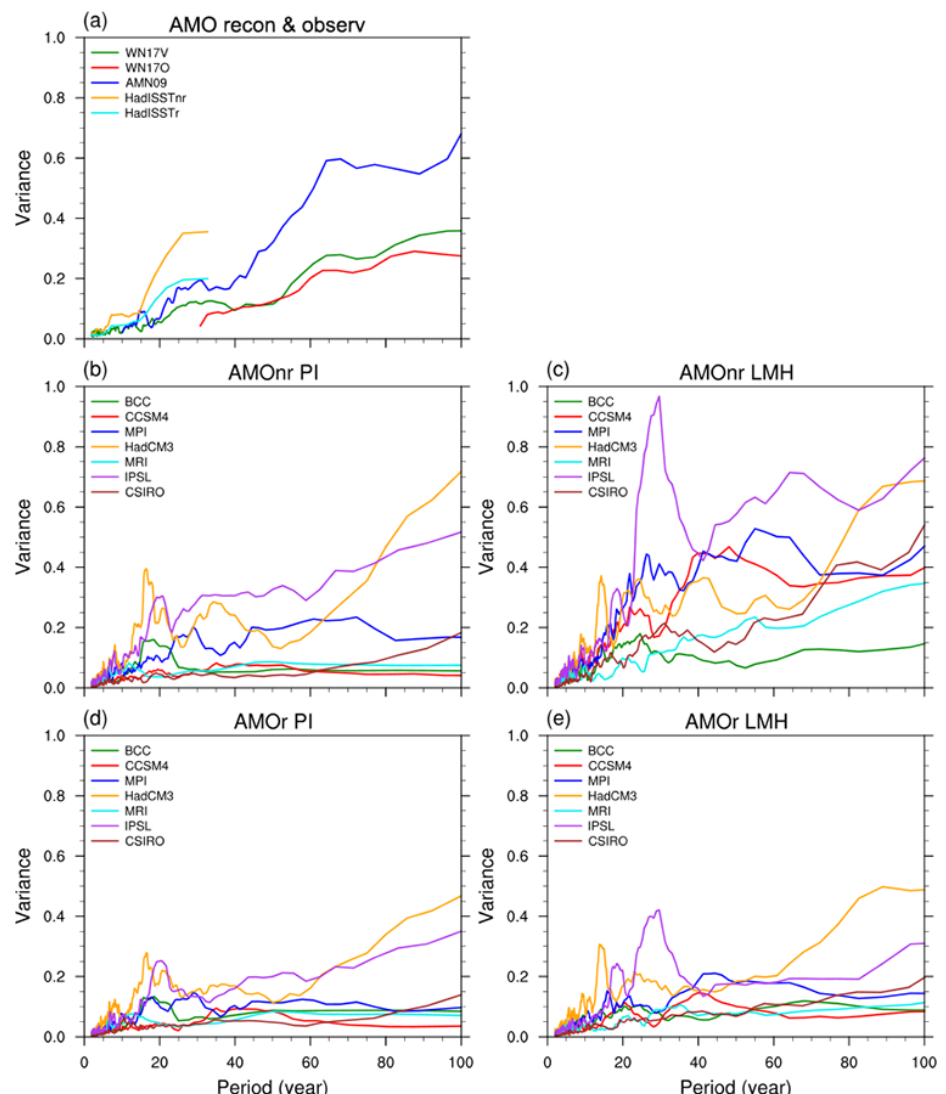
Figure 10. Spectra of AMO index of reconstructions and instrumental data (a) and each of seven GCMs for PI (b, d) and LMH (c, e) experiments. AMOnr and AMOr are the two definitions of AMO index described in Fig. 1. Spectra are not shown for timescales that the underlying data cannot adequately represent (not for <30 years for WN17O and not for <10 years for AMN09 because these reconstructions use 30-year and 10-year low-pass-filtered data, respectively, and not for >30 years for HadISST because the instrumental data are too short to determine power on longer